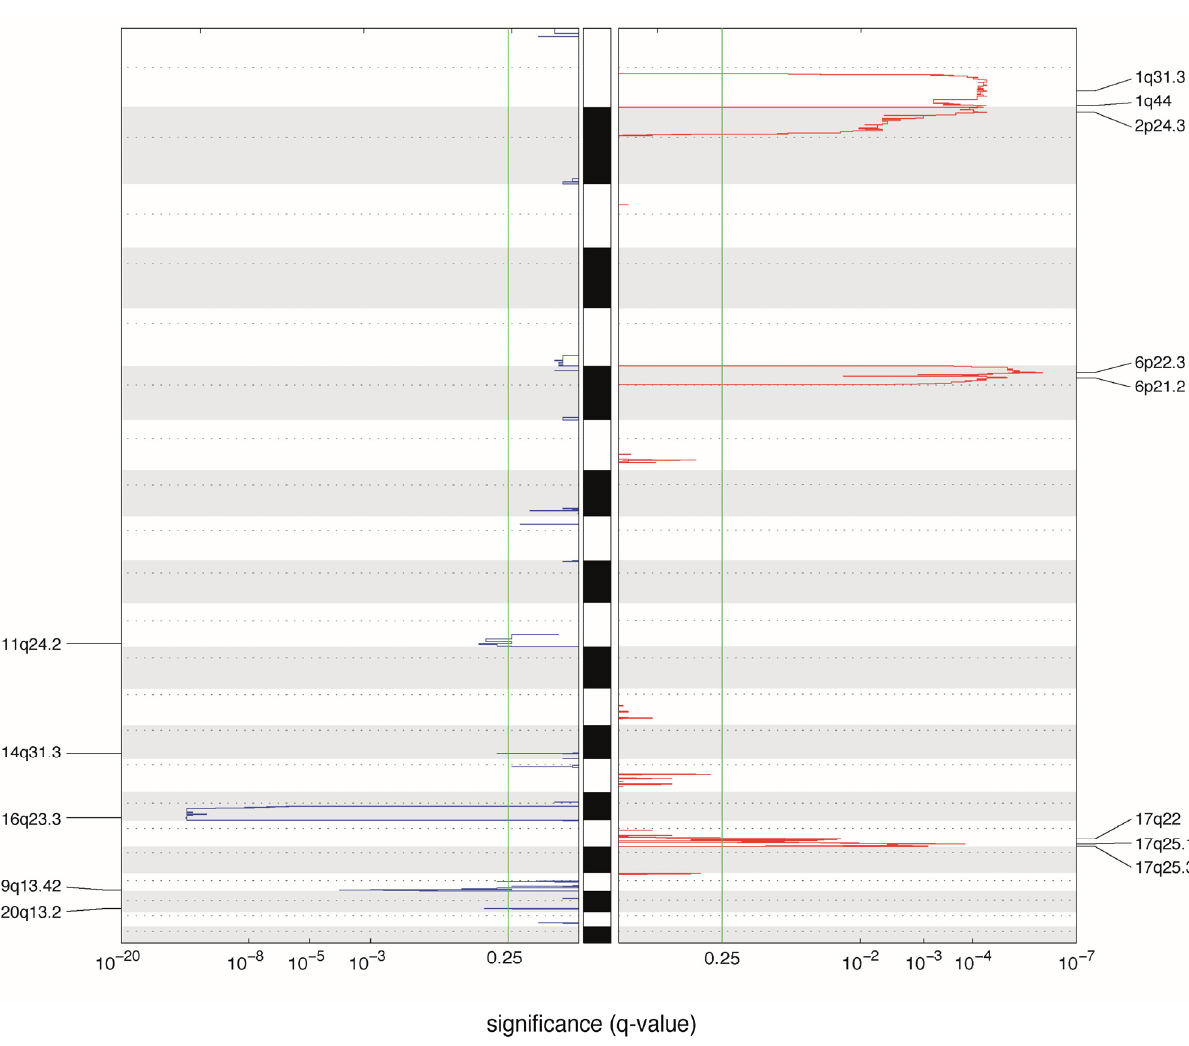
Figure 2. Significantly altered copy number regions identified by GISTIC. A karyogram overview of the cumulative copy number is shown separately for gains (red) and losses (blue) across the genome, depicted in the y-axis. In the x-axis, the GISTIC q-values are shown on a log scale and the green line represents the significance threshold ( q -value = 0.25). Significantly altered regions are mentioned on the sides. For this analysis, samples from Hospital Garrahan and Sant Joan de Deu were used. In cases where samples from primary site and metastatic site were available (patients RB5, RB11, RB12 and RB18), only the primary tumor results were considered.